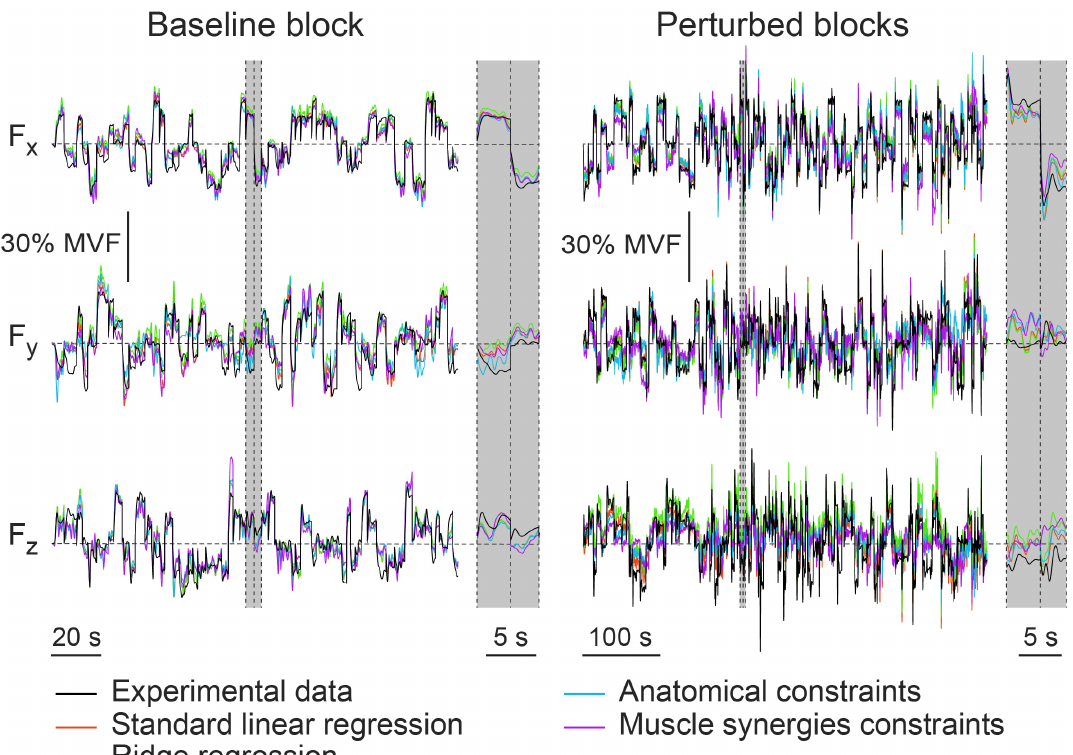
Figure 4. Example of the endpoint force data, fitted with EMG-to-force mapping calculated with different approaches. The experimental force data (black line), collected from a participant (#1) who practiced the protocol 2. The upper panels reported the force component collected along the x axis, the middle panels reported the force component collected along the y axis, and the lower panels reported the force component collected along the z axis. The left panels reported data collected during trials of the Baseline block, while right panels reported data collected during trials of the Perturbed blocks. Two trials of the Baseline block and of the Perturbed blocks, separated by vertical dashed lines, are highlighted in gray and magnified on the right portion of each panel.